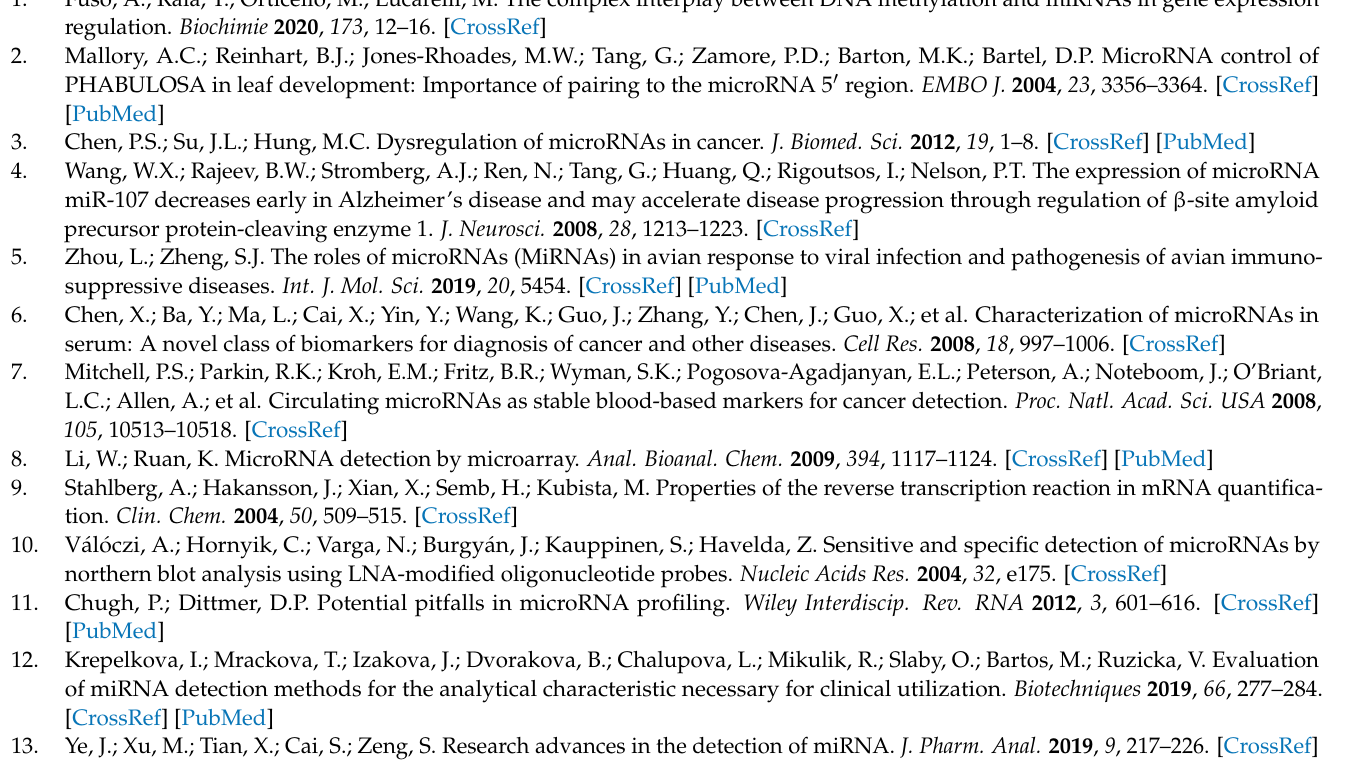
separation. Figure S2. M-H curve of lyophilized MNPs. Figure S3. Scheme for well plate based miRNA detection assay procedure in this study. Figure S4. Comparison of particle rinsing time during miRNA detection for single target between magnetic and centrifugal separation methods. Table S1. Sequences of DNA probes, miRNA targets and universal adapter. Table S2. Fluorescence signals of multiplexed detection of miR-18a, miR-29a, and